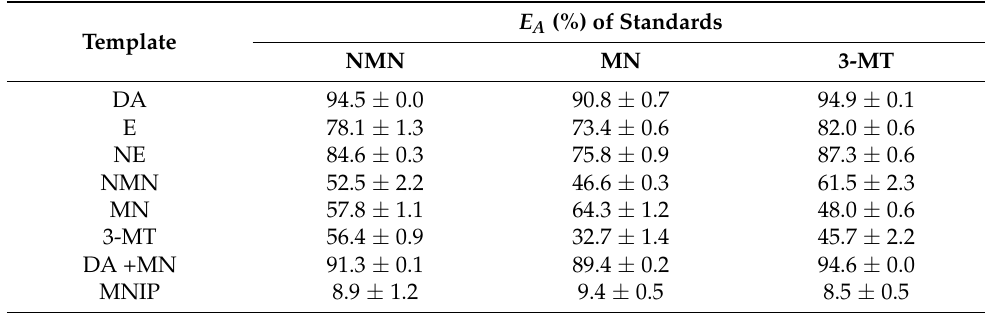
Table 1. The adsorption efficiency of synthesized MMIP of different template molecules. ( x ± s , n = 3).